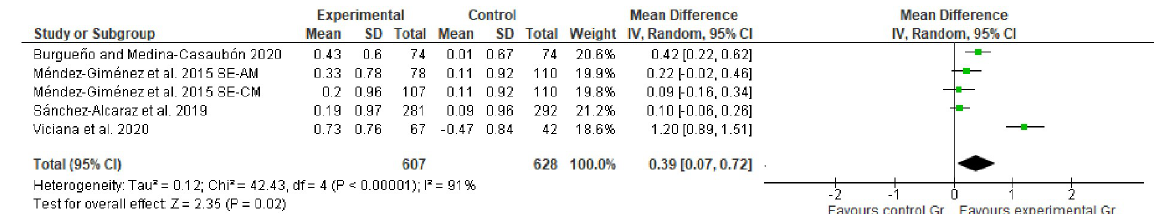
Fig 2. Results of the meta-analysis regarding the effects of interventions on the respect for the opponent.